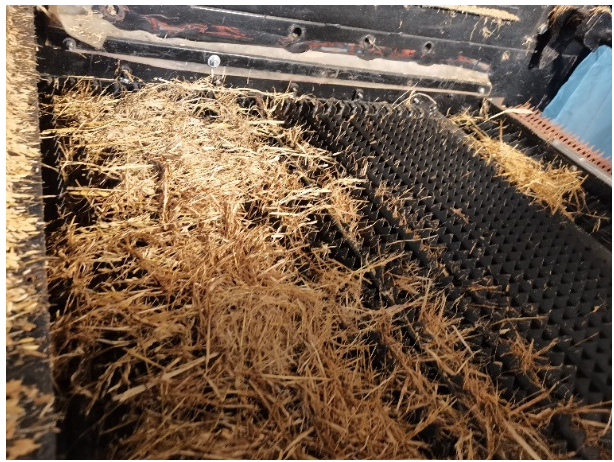
Figure 10. Snapshot of the cleaning screen surface.